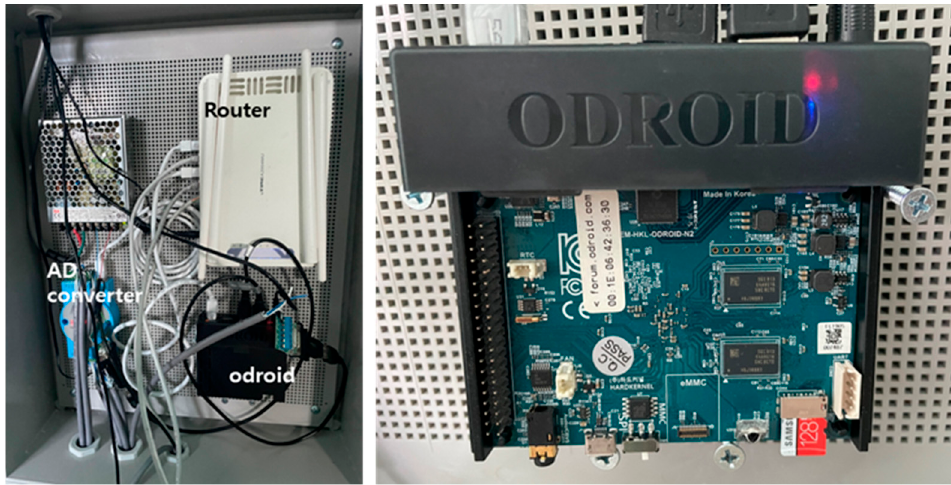
Figure 3. Monitoring devices installed on site.